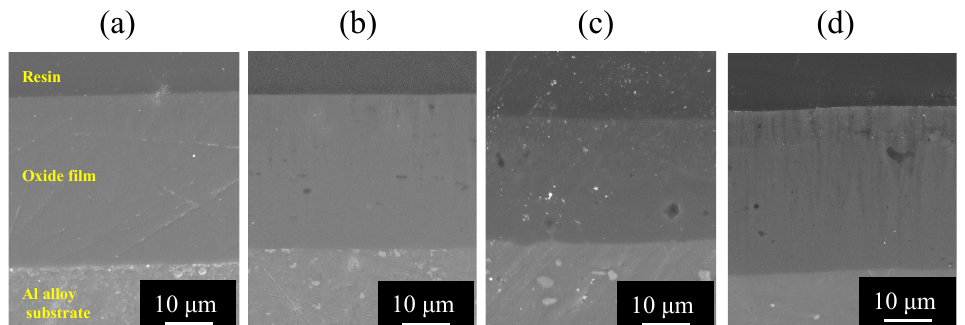
Figure 7. SEM images of the vertical cross section of ( a ) pure Al, ( b ) 1050-Al alloy, ( c ) 3003-Al alloy, and ( d ) 5052-Al alloy specimens with t a = 3600 s. Anodizing conditions are described in Figure 3.